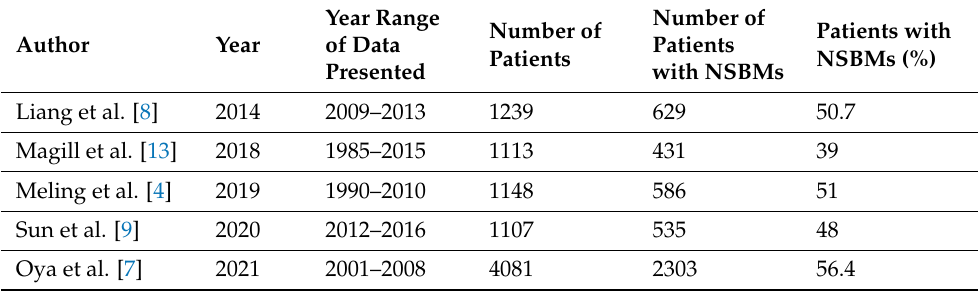
Table 1. Clinical Series of Supratentorial Non-Skull Base Meningiomas Reported in the